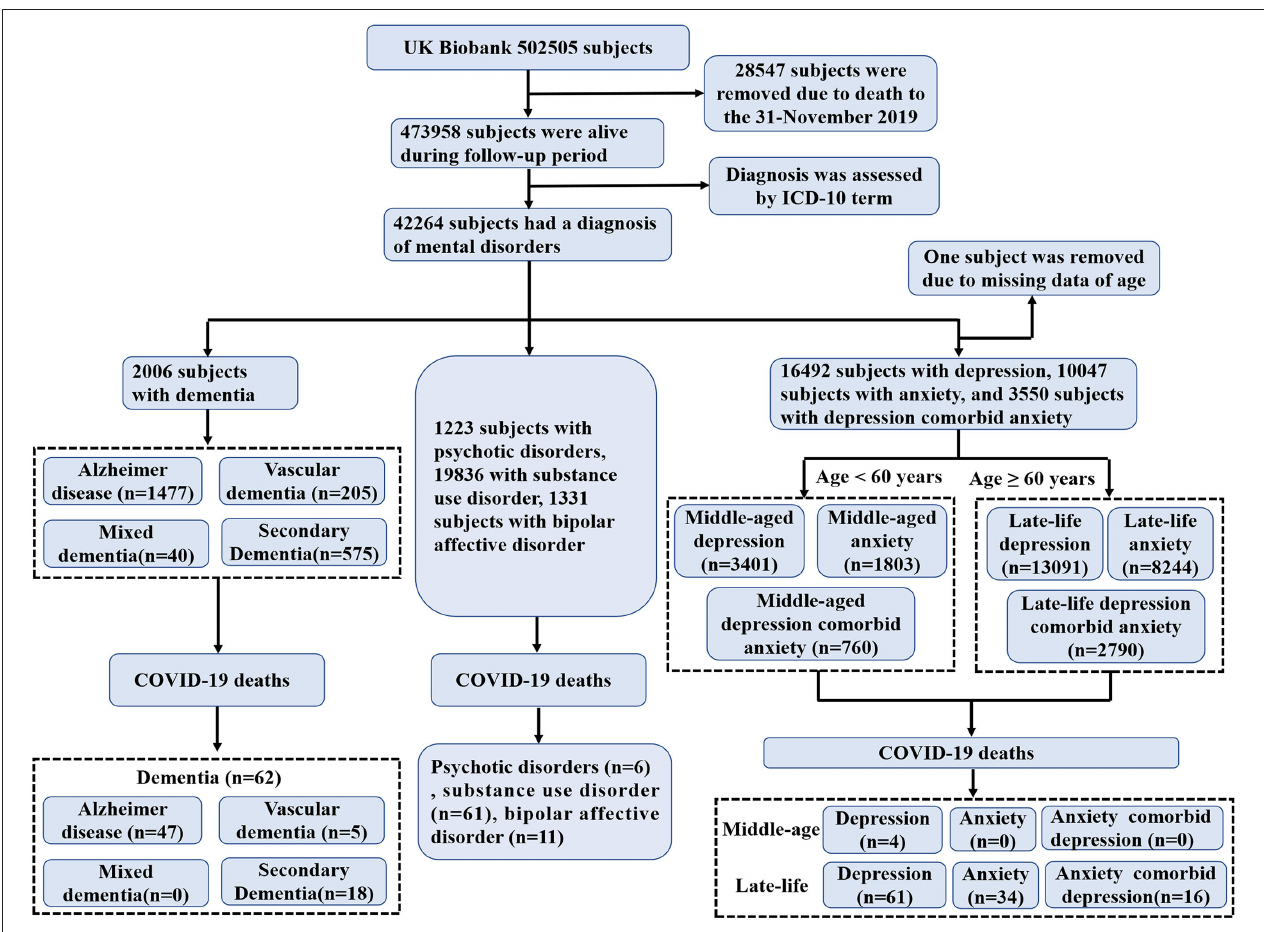
FIGURE 1 | Overview of study sample